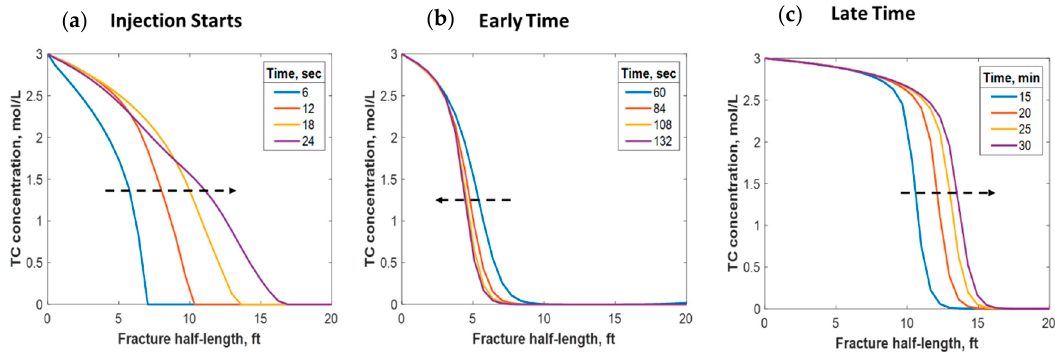
Figure 9. 1-D concentration profile of the TCs at ( a ) initial, ( b ) early, and ( c ) late injection times.